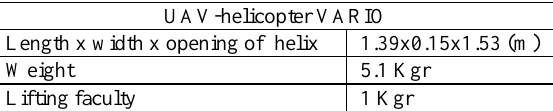
Figure 12. The location of the Neolithic settlement of Dispilio in W. Macedonia, Greece (a) and an aerial view of the archaeological site (b).